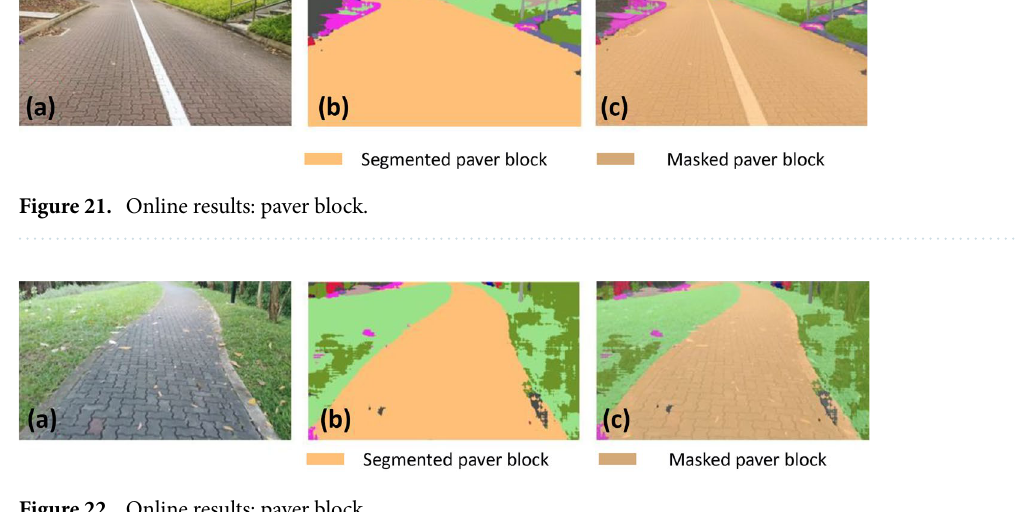
Figure 22. Online results: paver block.